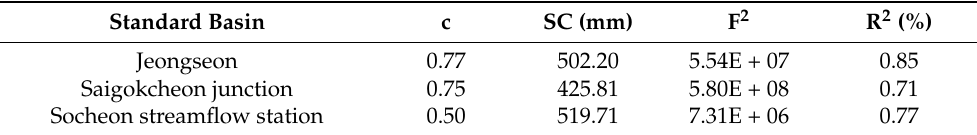
Table 5. Test results of the model